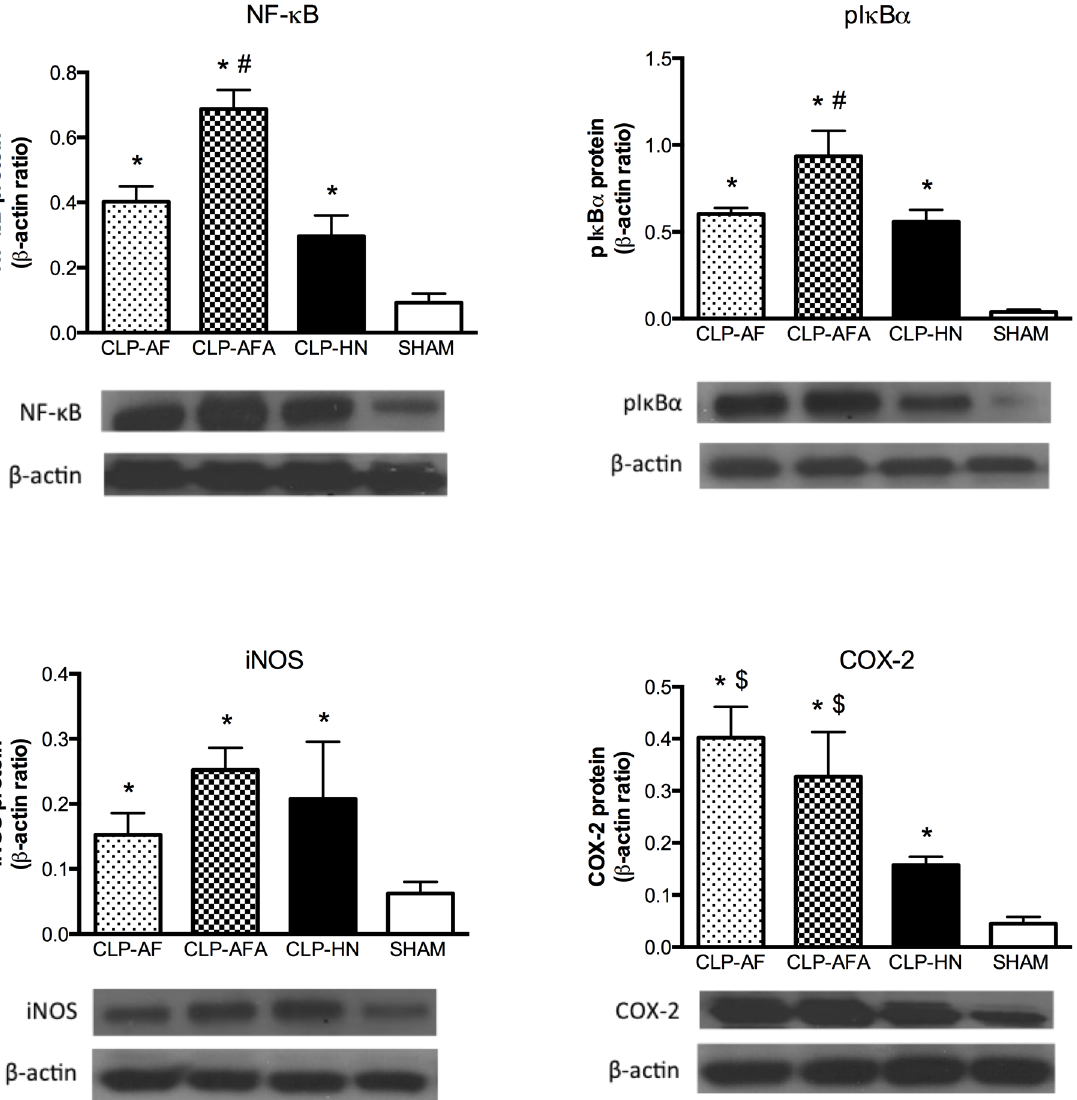
Fig 4. (A-D): A-B) NF- κ B p65/RelA expression and pI κ B- α content in mesenteric resistance artery (MRA) tissue homogenates from septic and SHAM rats treated with different enteral nutrition formulations: Peptamen 1 AF (AF), Peptamen 1 HN (HN), Peptamen 1 AF enriched arginine (AFA). Densitometry images are representative of six separate blots and mean ± SD densitometry values are expressed in arbitrary units (A.U.) relative to β -tubulin content. Different enteral nutrition formulations were as follows: Peptamen 1 AF (AF), Peptamen 1 HN (HN), Peptamen 1 AF enriched arginine (AFA). * p < 0.05 vs. all the other groups, # p < 0.05 vs. SHAM rats, & p < 0.05 vs. CLP-AF rats, $ < 0.05 vs. CLP-HN rats. n = 5 for SHAM group and n = 12 for CLP-HN, CLP-AF and CLP-AFA